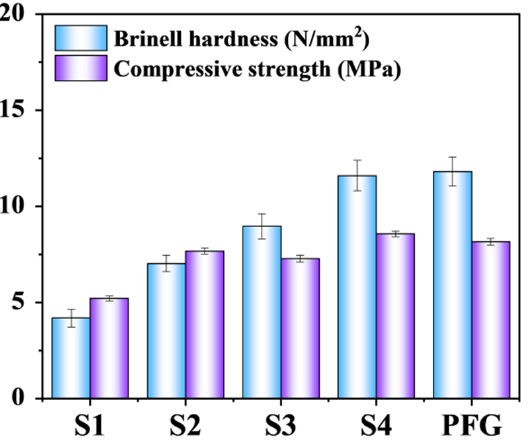
Figure 5. Brinell hardness and compressive strength values of the different grinding wheels.